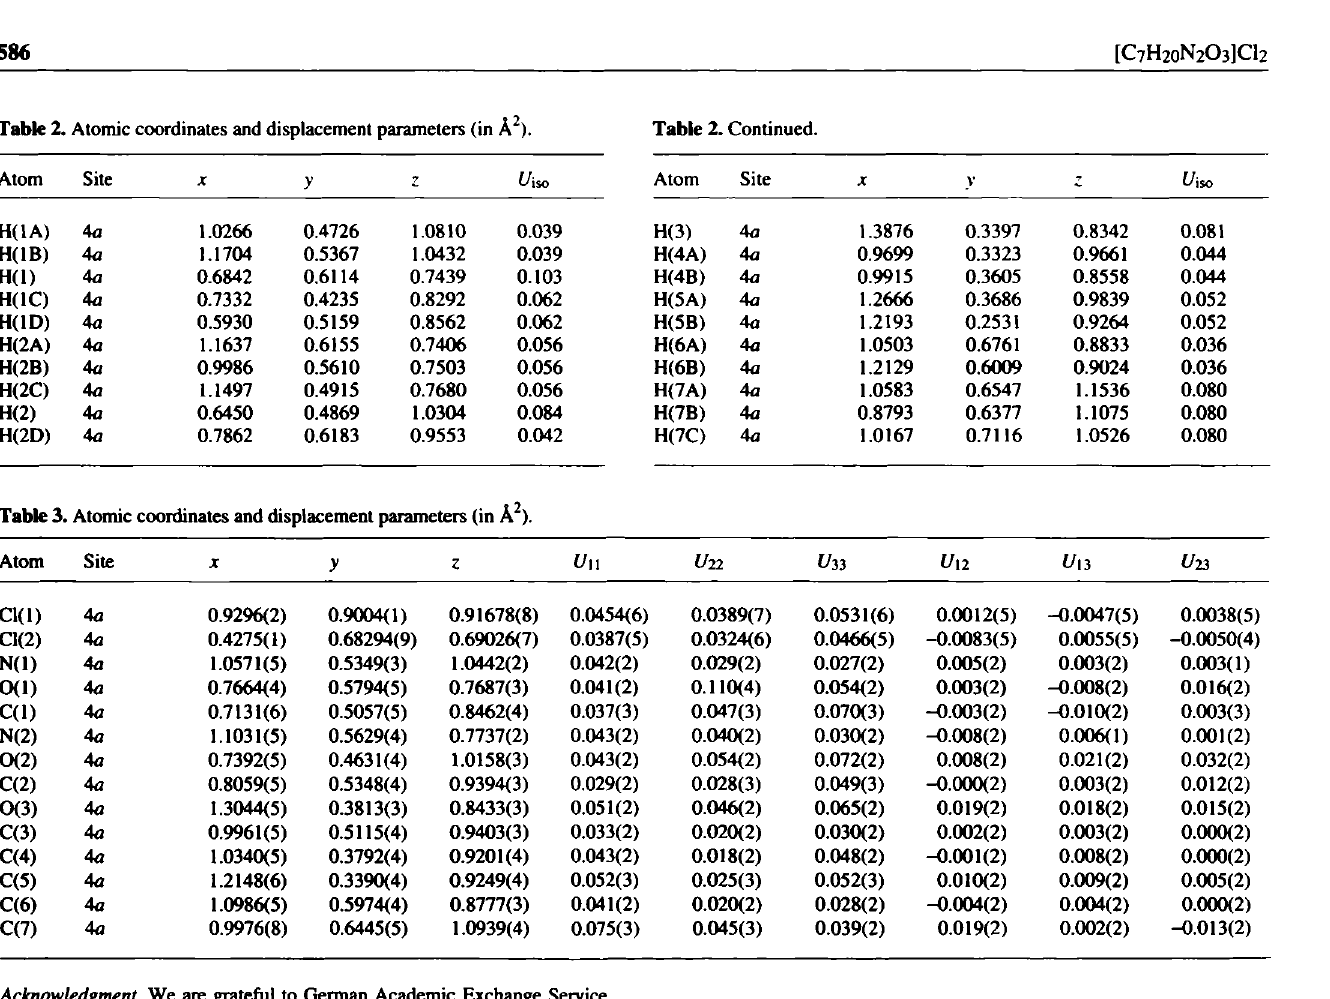
Table 2. Atomic coordinates and displacement parameters (in À 2 ).